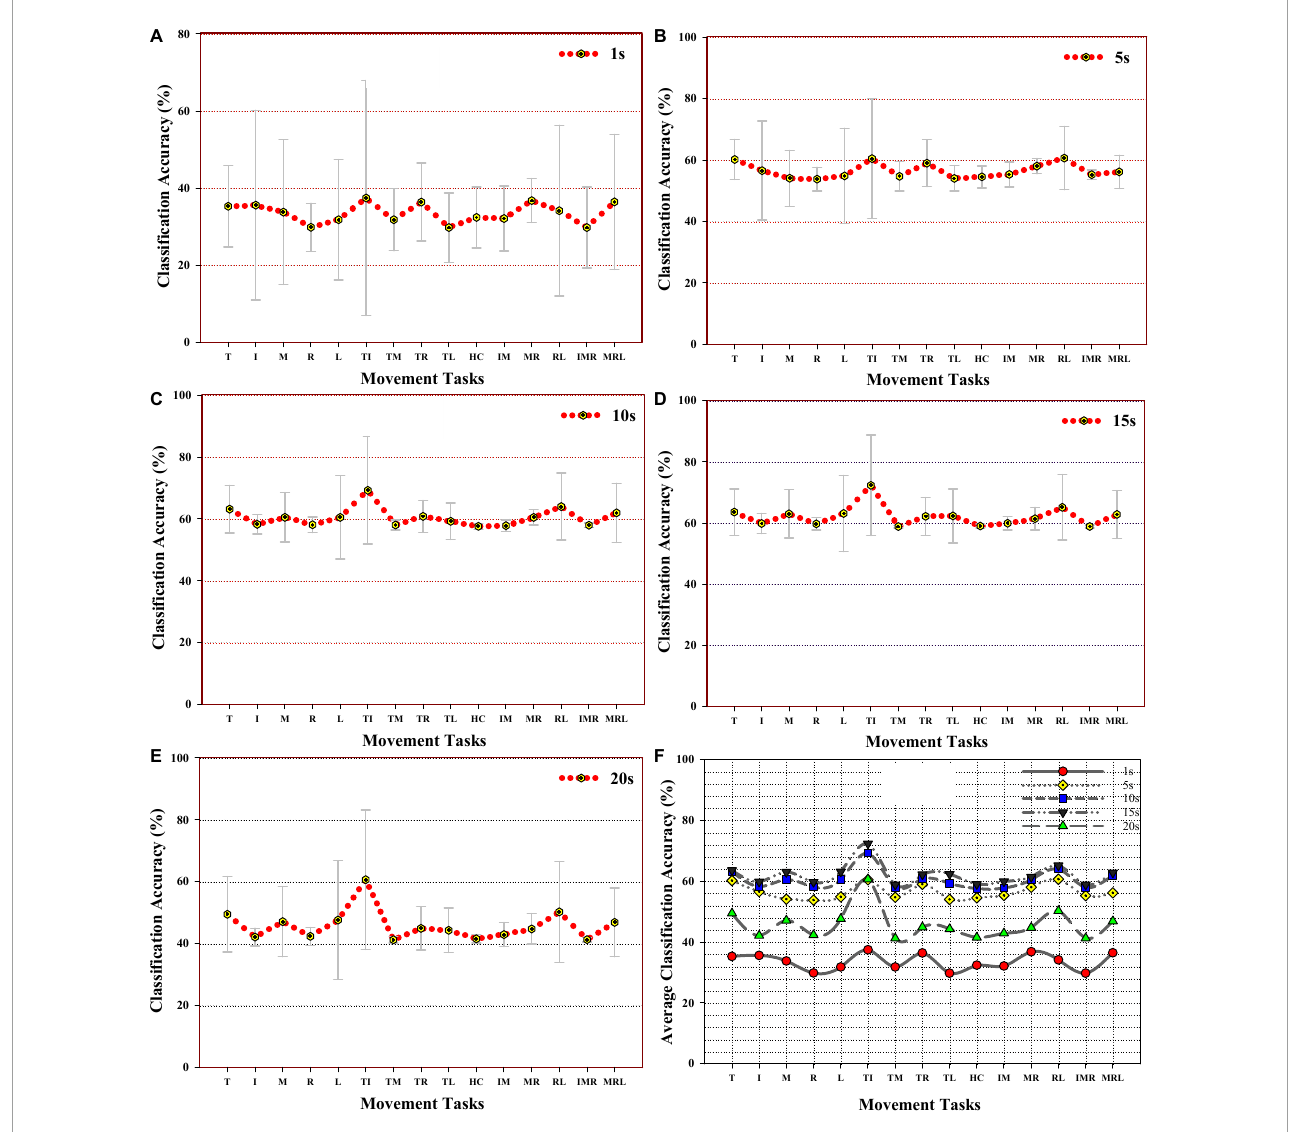
FIGURE6 Average decoding performance across subjects for individual finger gesture using the combination of NTDF feature and LDA classifier for (A) 1 s, (B) 5 s, (C) 10 s, (D) 15 s, and (E) 20 s, (F) multiple splines curve lines and scatter plot showing performance comparison among the motion